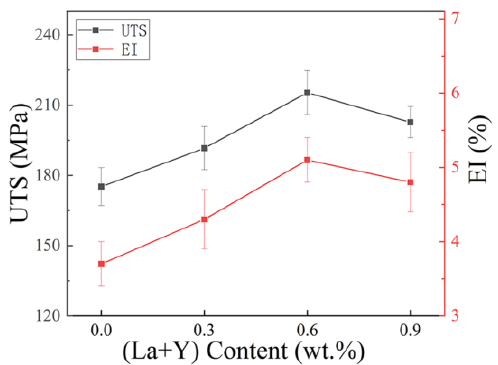
Figure 6. Mechanical properties of A380 alloys with different (La+Y) contents.